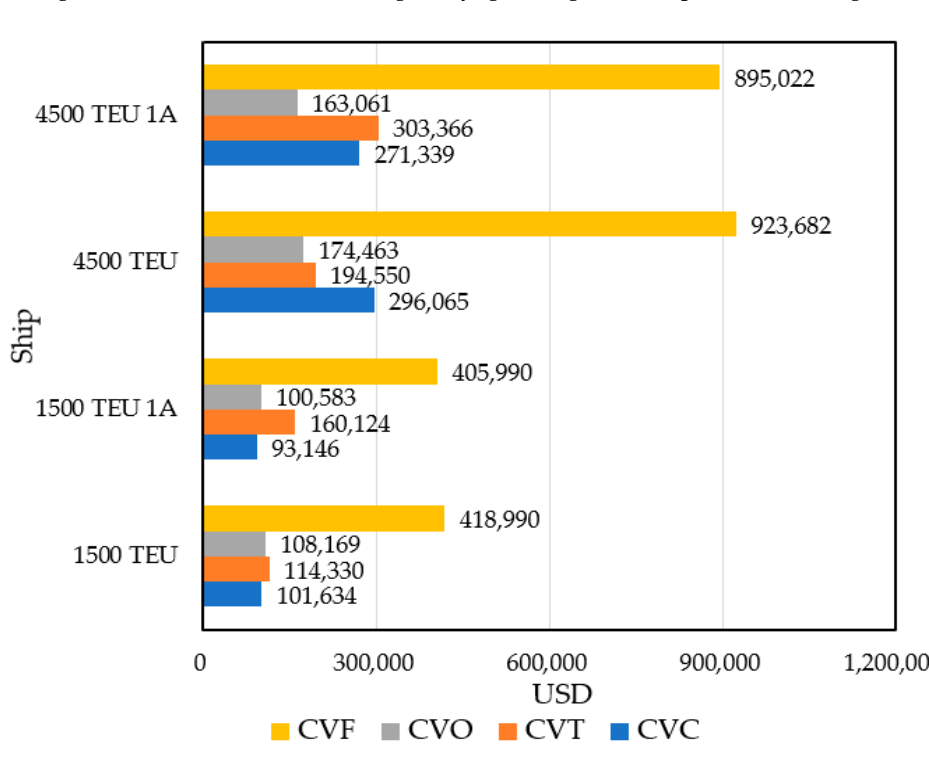
Figure 7. Voyages cost analysis for Europe sea route and Northeast Passage.